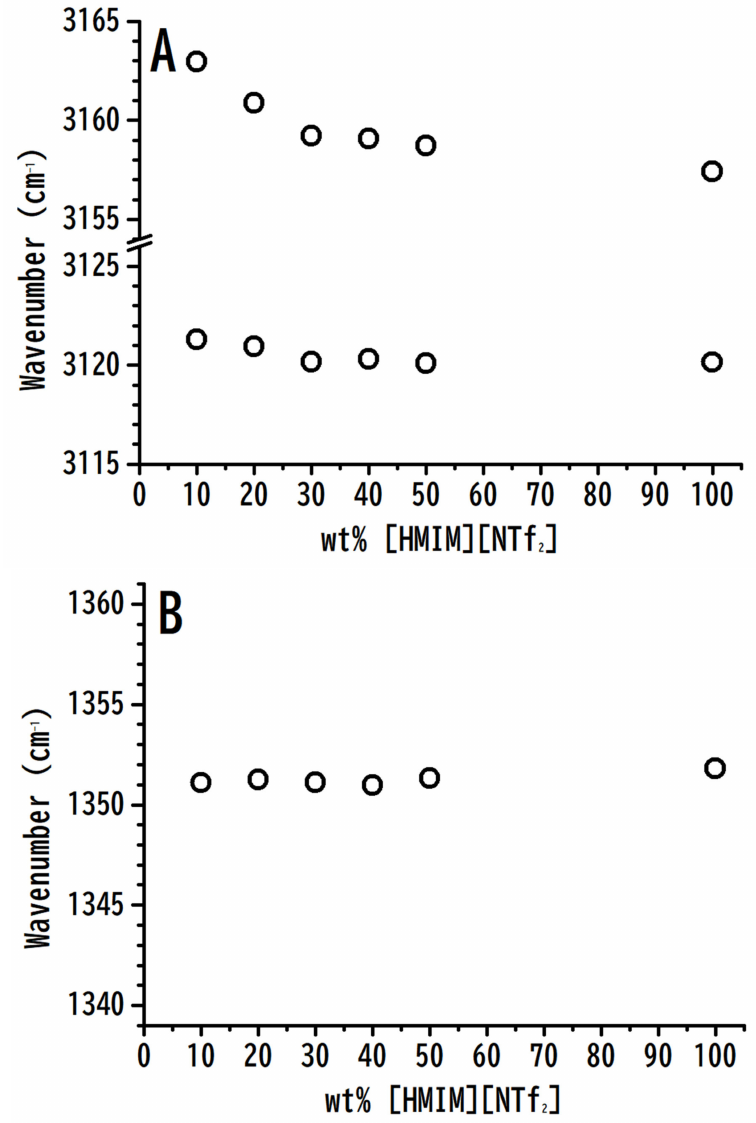
Figure 3. Concentration-dependence of the ( A ) imidazolium C 4,5 –H and C 2 –H, and ( B ) anionic ν a SO 2 stretching bands of [HMIM][NTf 2 ] / PVdF-co-HFP mixtures versus the wt.% of [HMIM][NTf 2